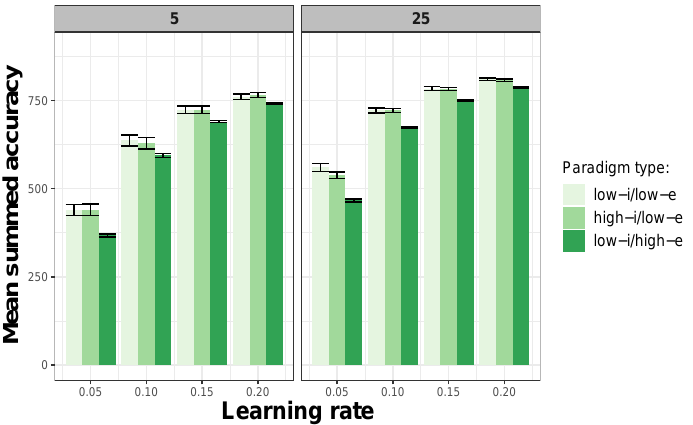
Figure 12: Summed accuracy over the 900 epochs of the networks trained on each of the three paradigm types for models with different learning rates ( x axis) and for models with different dimensions (columns) optimized with SGD